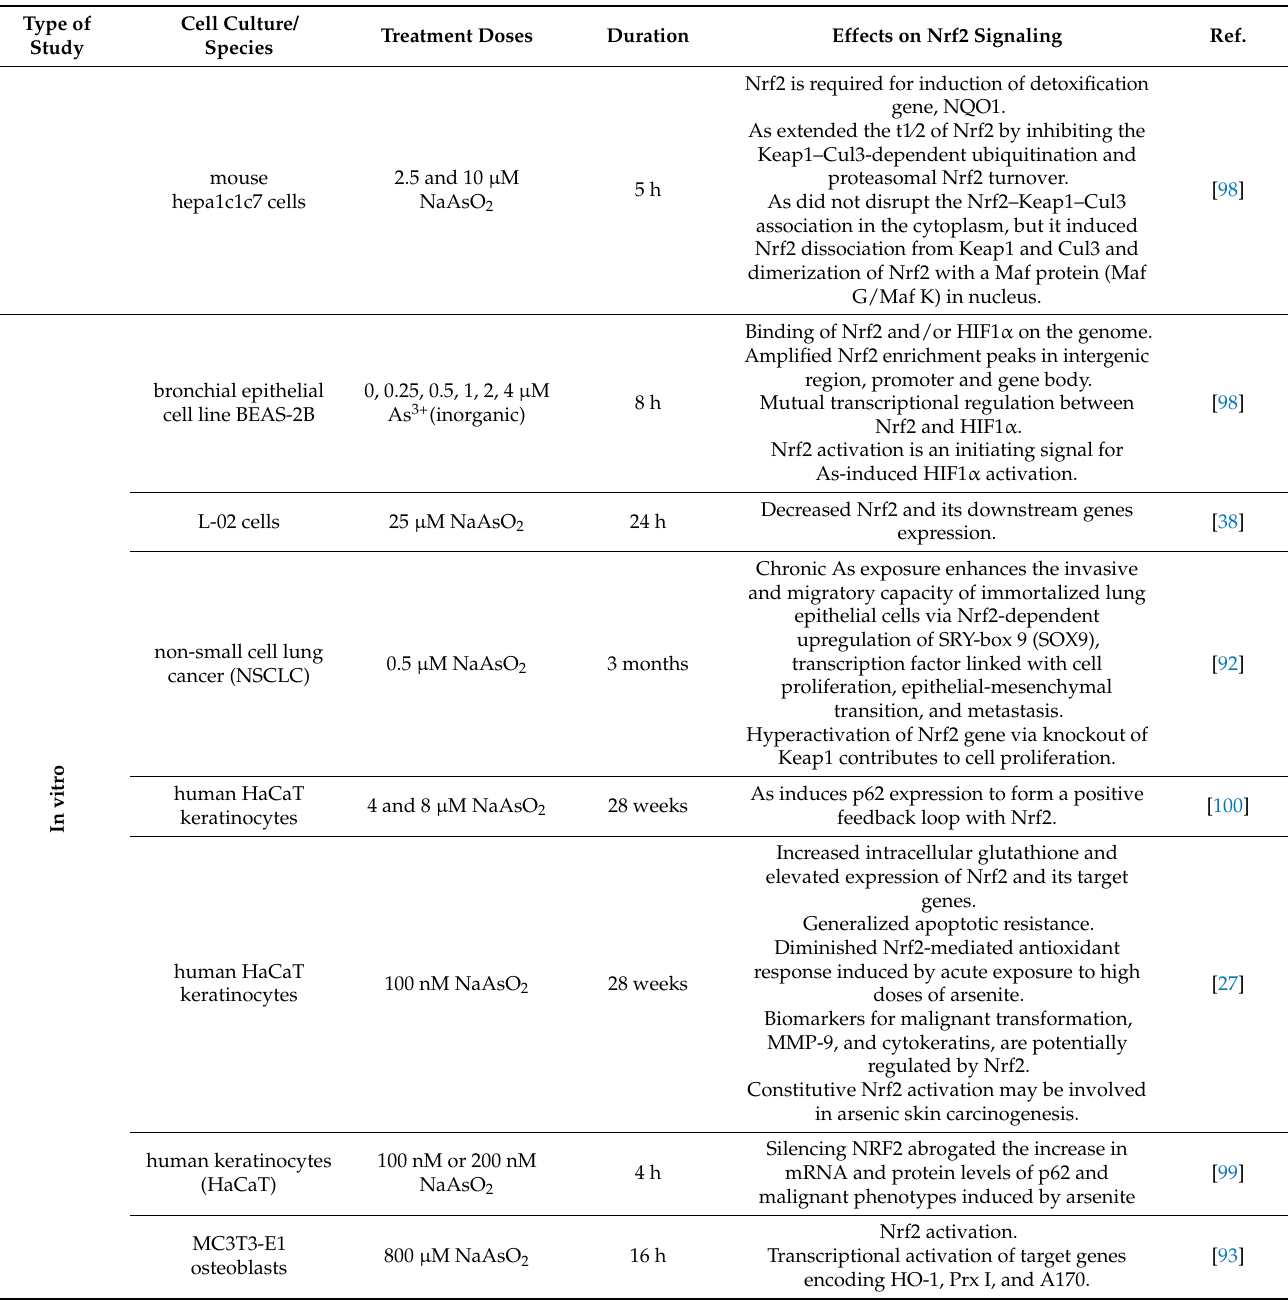
Table 3. Summary of the studies analyzing the effects of As on Nrf2